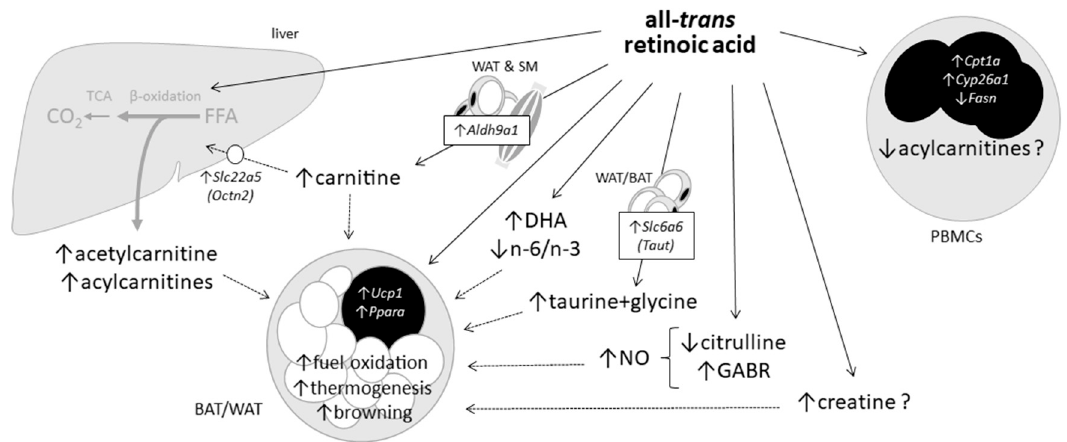
Figure 7. Effects of short-term, high-dose all-trans retinoic acid (ATRA) treatment in mice revealed in this work and suggested connection to oxidative metabolism in adipose tissues. Direct or indirect ATRA effects on metabolite levels and gene expression are indicated by arrows. Question marks are used to distinguish observed trends from statistically significant effects.